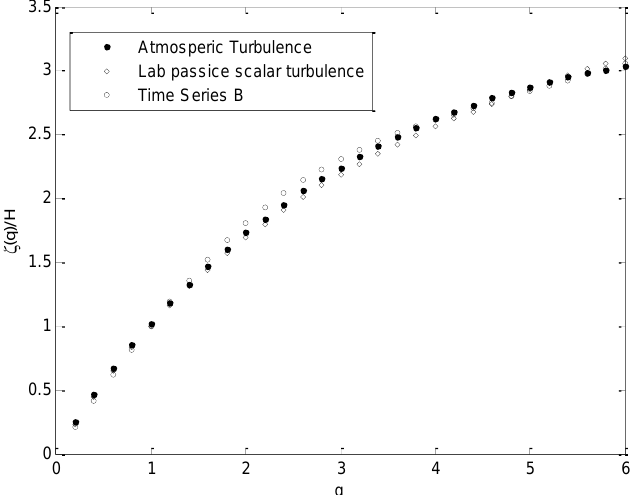
Figure 8. Our estimates of ζ( q ) plotted versus q for moments up to 6.0, compared to other databases: atmospheric turbulent temperature data ( H = 0.38, Schmitt et al. [21]) and laboratory passive scalar turbulence ( H = 0.37, Ruiz et al. [33]).